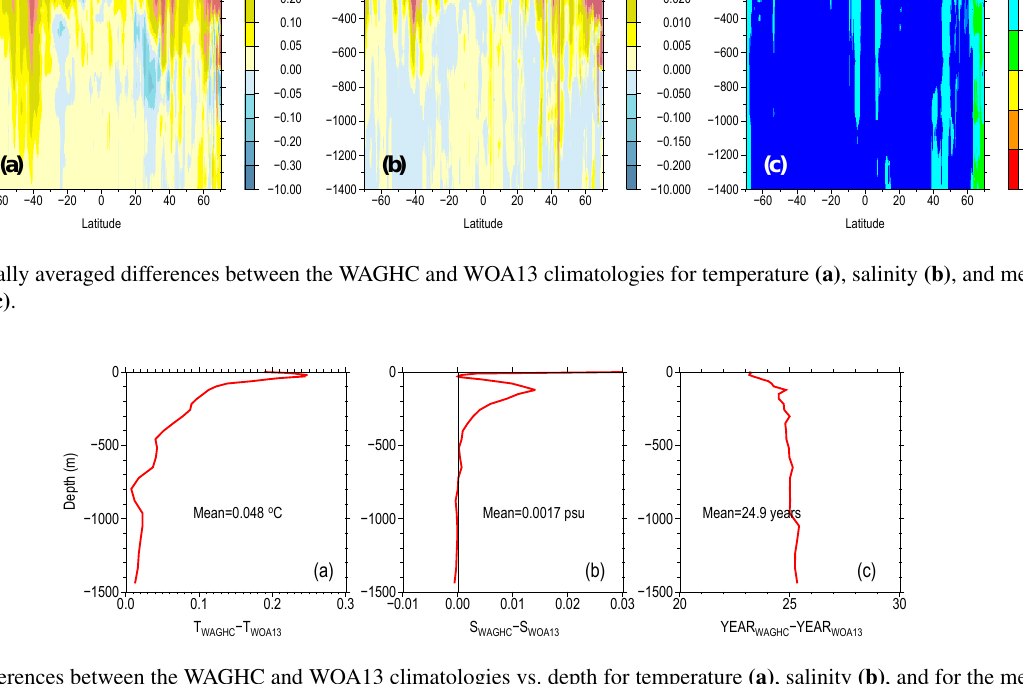
Figure 15. Differences between the WAGHC and WOA13 climatologies vs. depth for temperature (a) , salinity (b) , and for the mean clima- tological year (c)